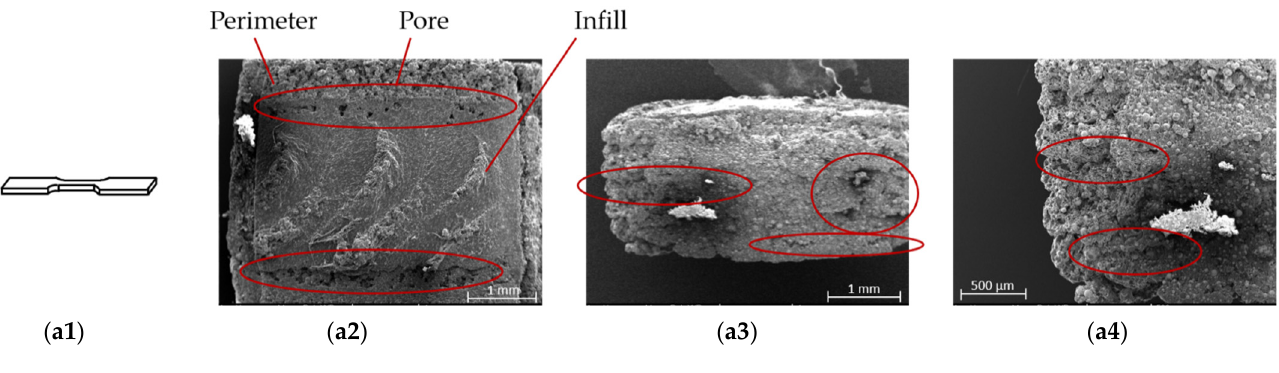
Figure 9. Tensile stress–strain curves of metal parts from test No. 1, 2, 4, and 5 in Table 3.